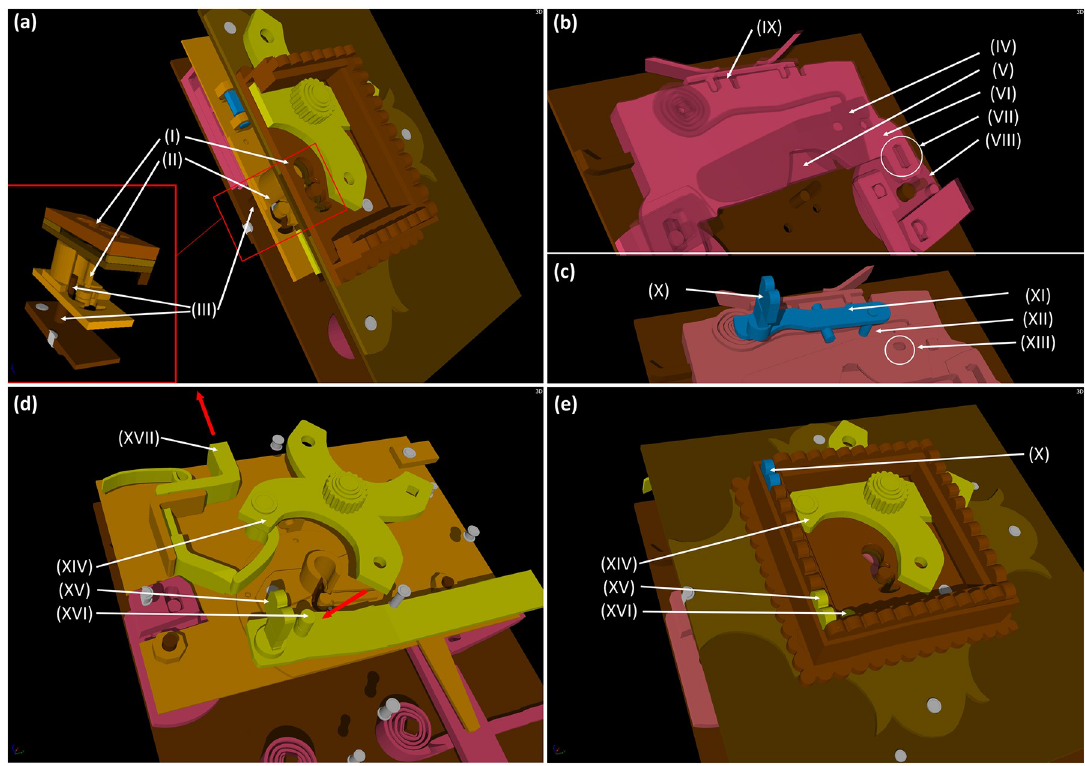
Fig 5. A 3D model of the lock mechanism from the CT data; (a): a cross section with a detail of the keyhole depicting: (I) the keyhole, (II) the second aperture of the lock and (III) the peg onto which the key shank is being slid; (b): first mechanism: (IV) the catcher, depicted semi-transparent, (V) the arresting plate, partly hidden by (VI) the bar, (VII) the missing peg that should connect the bar with the (VIII) guiding wheel, (XI) the detents of the bar with the arresting plate fit in the unlocked position; (c): parts of the third mechanism depicted in blue: (X) the secret button, (XI) the cradle, (XII) the peg, which was supposed to fit in (XIII) the hole to block the catcher; (d +e): parts of the second mechanism depicted in yellow as seen on the lid of the chest: (XIV) the X-shaped cap covering the keyhole, (XV) the secret button, (XVI) the peg supposed to fix the cap in the closed position, ( XVII ) a little lever transferring the motion of the X- shaped cap onto the main lever with the bolts (see Fig 4), direction of the motion to the opened position is marked by the red arrows, ( X ) the third mechanism secret button depicted in blue.